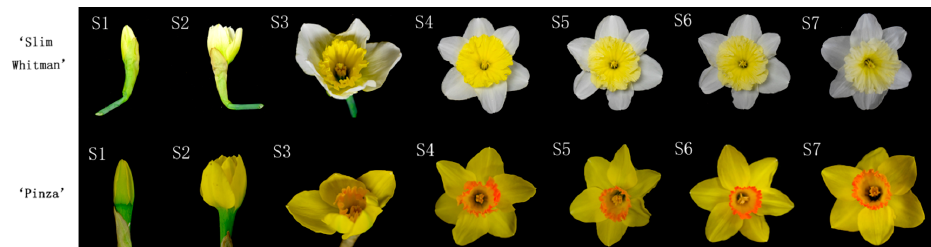
Figure 1. Phenotypic characters of flowers in different stages. S1–S4: from flower bud to blooming